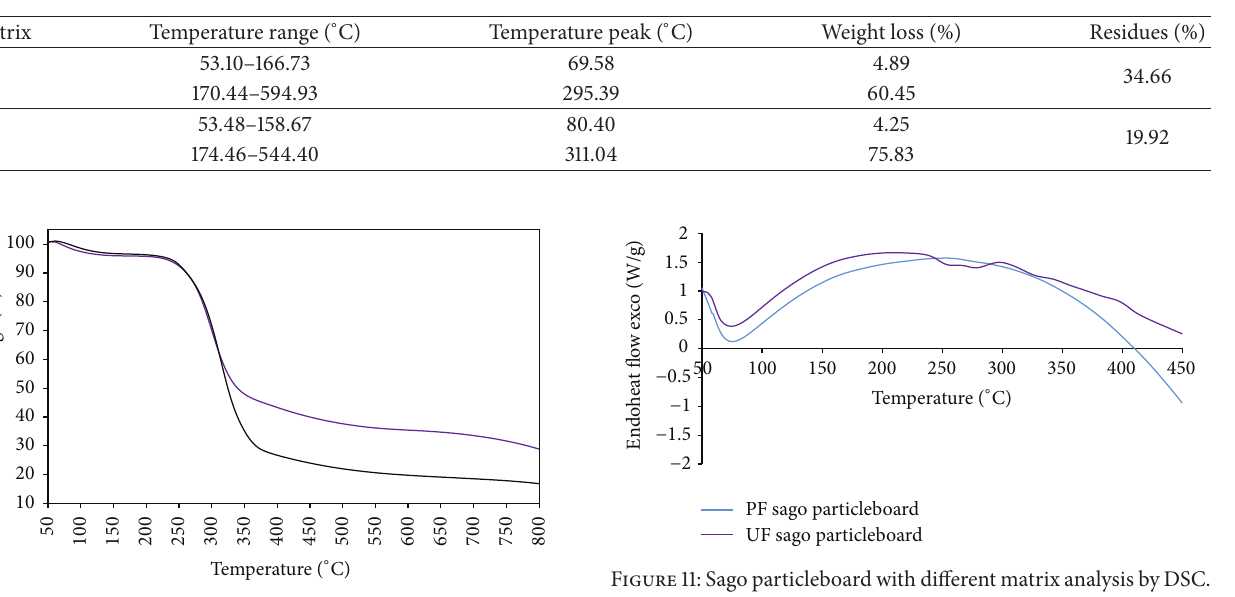
Table 4: Results for sago particleboard with different matrix analysis by TGA.